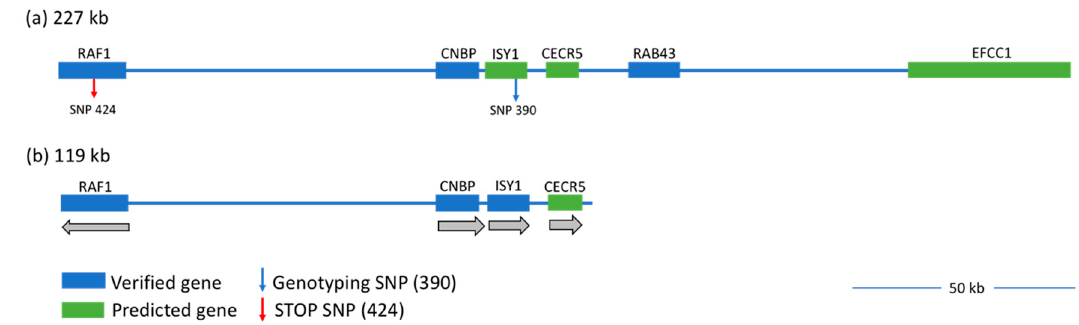
Figure 2. The wg-2 linked region of chromosome 12 is shown at different stages of genomic analysis. The candidate region initially spanned 227 kb ( a ), from chr12:4,958,991–5,185,627 on build galGal5 and contained six genes: three verified (blue) and three predicted (green). The diagnostic SNP 390 is indicated (blue arrow to the right within ISY1 ) and is identifiable in NCBI dbSNP as rs14034687. The premature STOP SNP in RAF1 (red arrow to the left) is identified as SNP 424 (rs314452077). The newly-identified and smaller linked region of 119 kb is indicated in ( b ) with genes eliminated from the 3’ end ( EFCC1 , RAB43 ) and additional intergenic DNA no longer linked to wg-2 (new 3’ endpoint: 5,078,217). CNBP , the predicted gene CECR5 , and part of RAF1 (14,462 nt of 27,936 total) remain in the candidate region, as well as ISY1 , updated as a validated gene here (blue), as our results showed ISY1 transcripts present in chicken embryos. Grey arrows below each gene (in ( b )) indicate the direction of transcription along the strand. Note that as RAF1 is transcribed on the opposite strand, the 5’ end of the transcript is retained in this linked region. A 50-kb bar is included for scale.